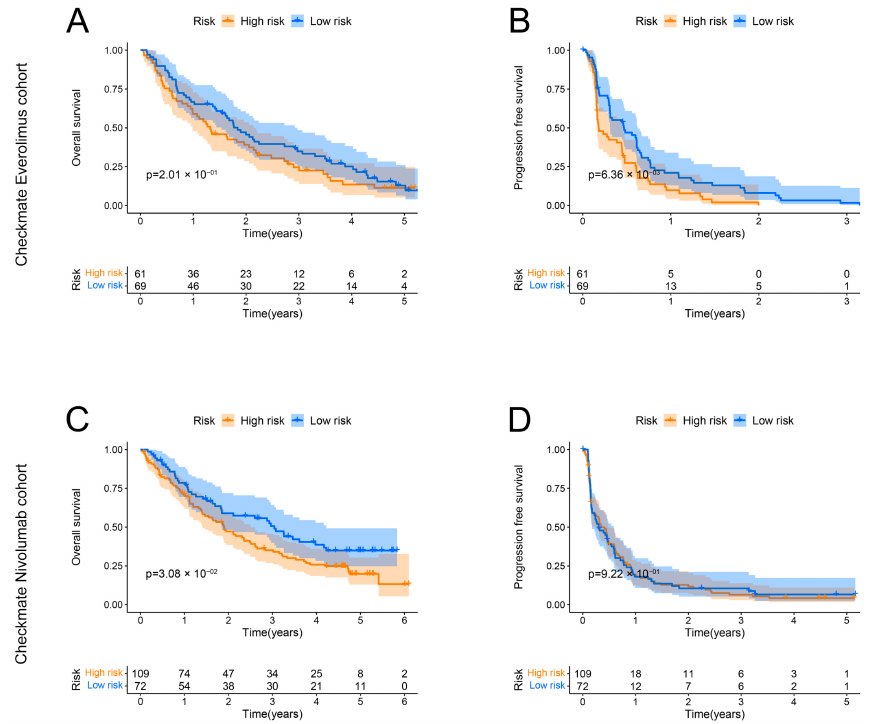
Figure 10. Validation of the IRRS in the Checkmate dataset. ( A , B ) OS and PFS of ccRCC patients treated with everolimus in both risk groups. ( C , D ) OS and PFS of ccRCC patients treated with nivolumab in both risk